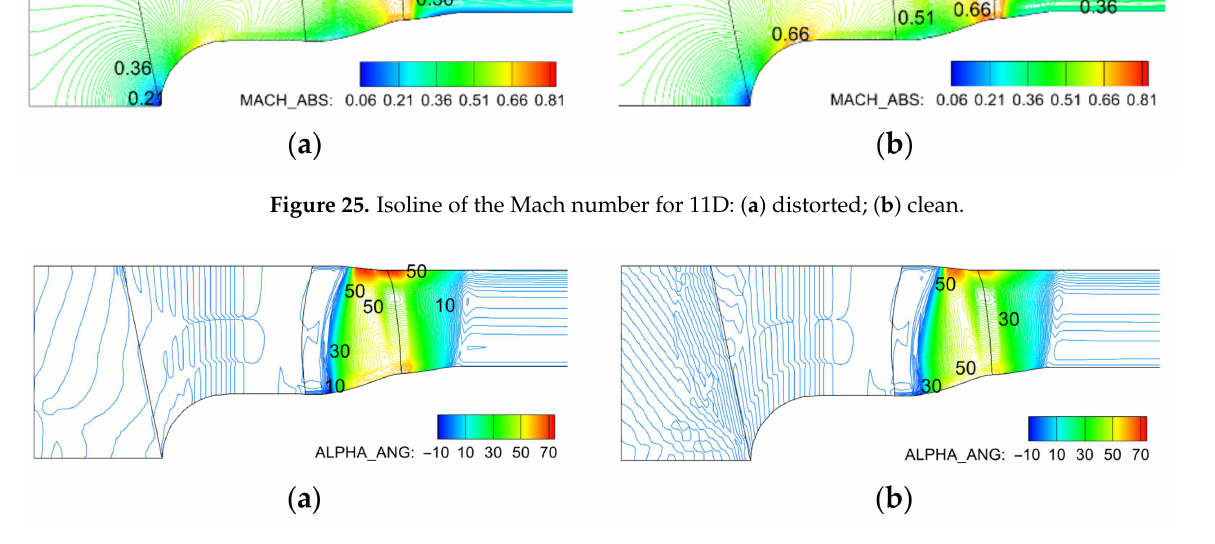
Figure 26. Isoline of the flow angle for 11D: ( a ) distorted; ( b )